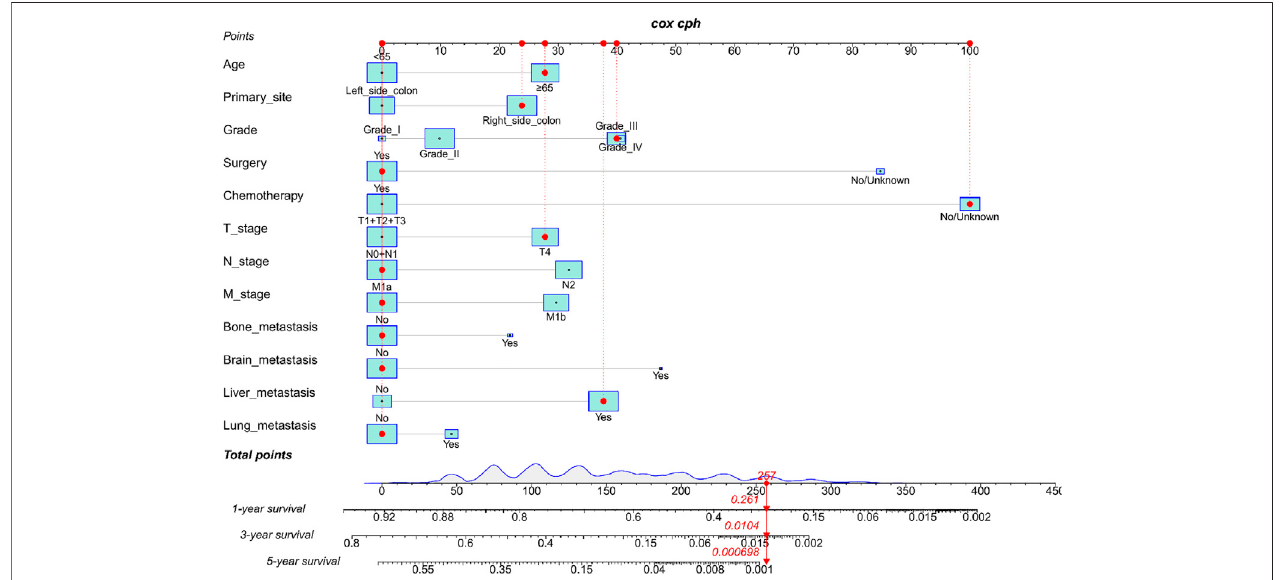
FIGURE 3 | Nomogram for predicting 1-,3-, and 5-year overall survival (OS) for mCC; patients in the training cohort.